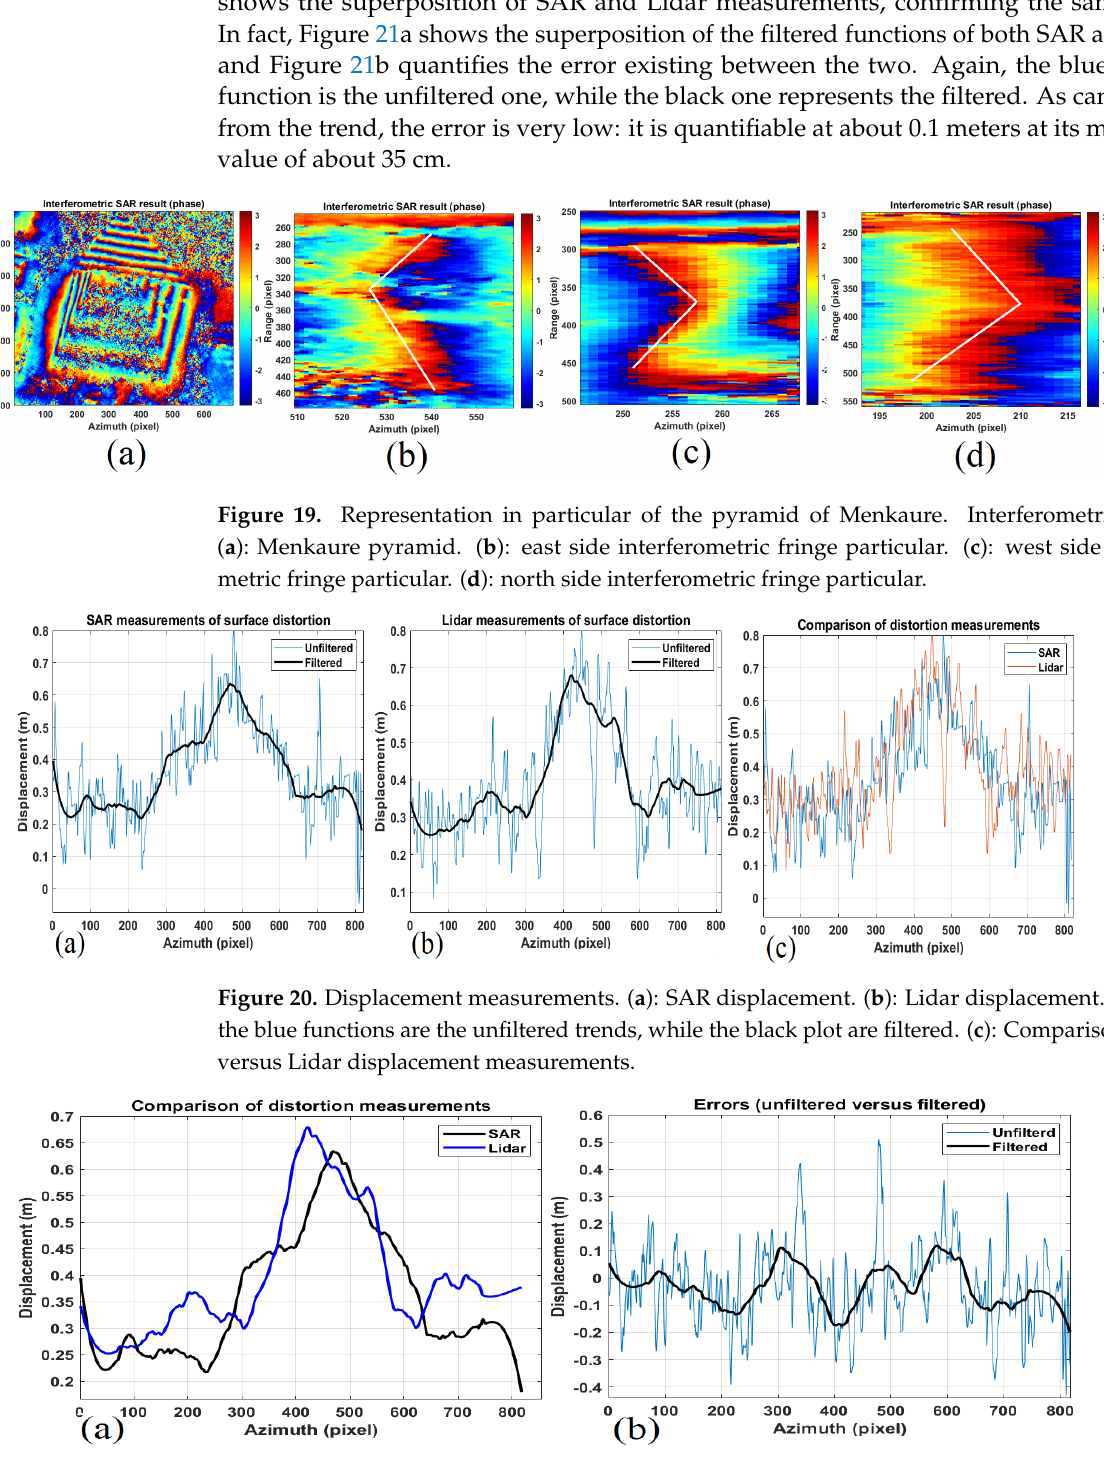
Figure 21. ( a ): Filtered displacement measurements. ( b ): Errors between SAR and Lidar displace- ment